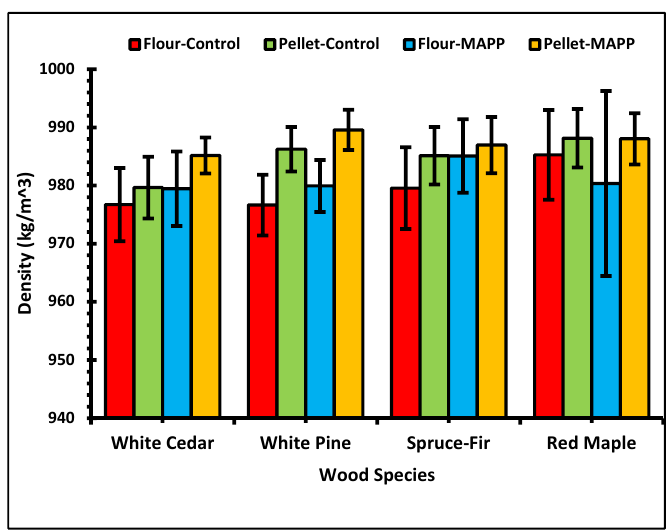
Figure 4. Density of WPCs.